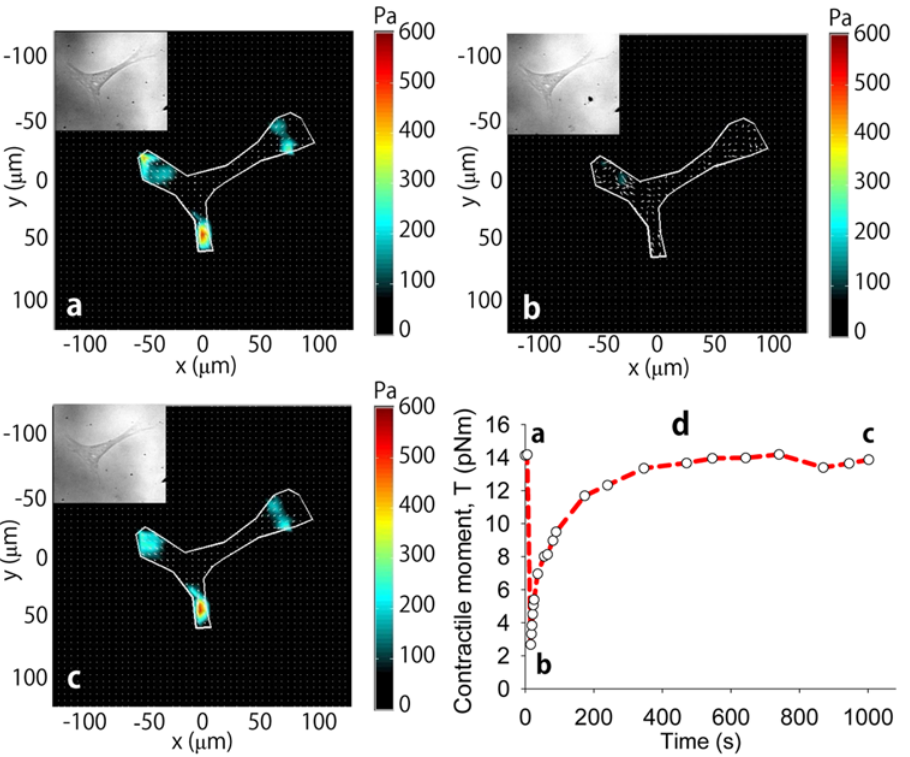
Figure 2. CMR measurements for a representative cell. a , Traction map before cell stretch. b, Traction map measured immediately after an imposed homogeneous biaxial stretch of a 4 second stretch-unstretch maneuver with a peak strain amplitude of 10%. The cell tractions are markedly ablated. c, Traction map measured at 1000 seconds following stress cessation. Tractions have largely recovered to the baseline pre-stretch value measured in (a). d, The traction field can be used to compute the contractile moment, T, corresponding to an equivalent force dipole.[14] At the earliest measurable time point following stretch (b), the contractile moment was significantly reduced to 20% of its baseline value (a) followed by a slow recovery